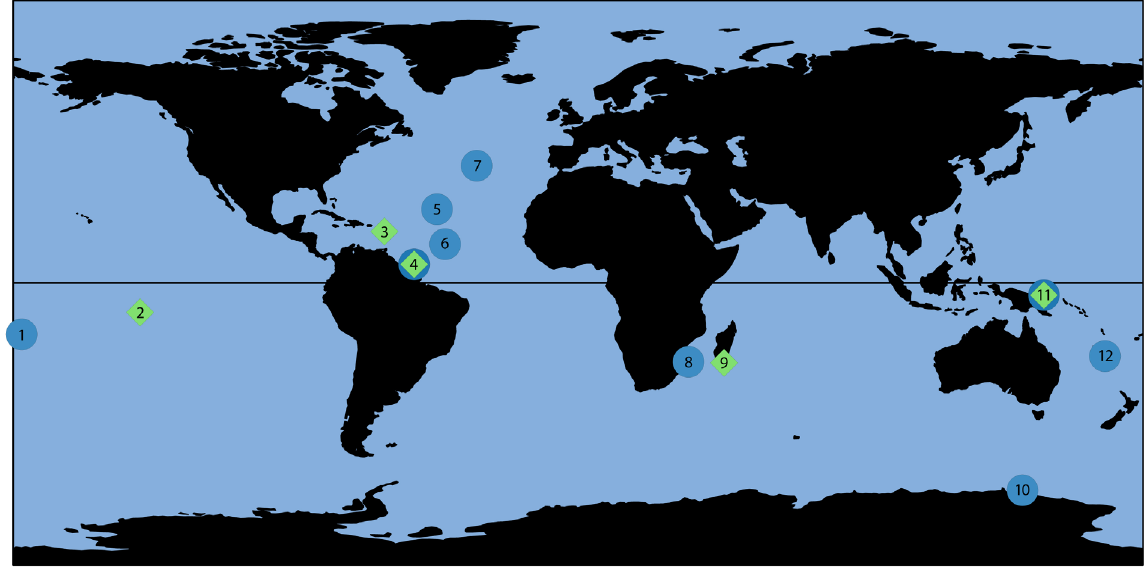
Fig. 2. Regional distribution of the studied specimens. Green diamonds indicate locations where specimens were collected at shallow depths (< 100 m), blue circles those from deep-sea samplings; the combinations of both symbols indicates mixed samplings (below and above 100 m depth). 1: Futuna; 2: Marquesas Islands; 3: Guadeloupe; 4: French Guiana; 5: Mid-Atlantic Ridge, Snake Pit site; 6: Mid- Atlantic Ridge, Logatchev site; 7: Mid-Atlantic Ridge, Lucky Strike site; 8: Mozambique Channel; 9: South Madagascar; 10: Antarctica, Terre Adélie; 11: Papua New Guinea; 12: New Caledonia and